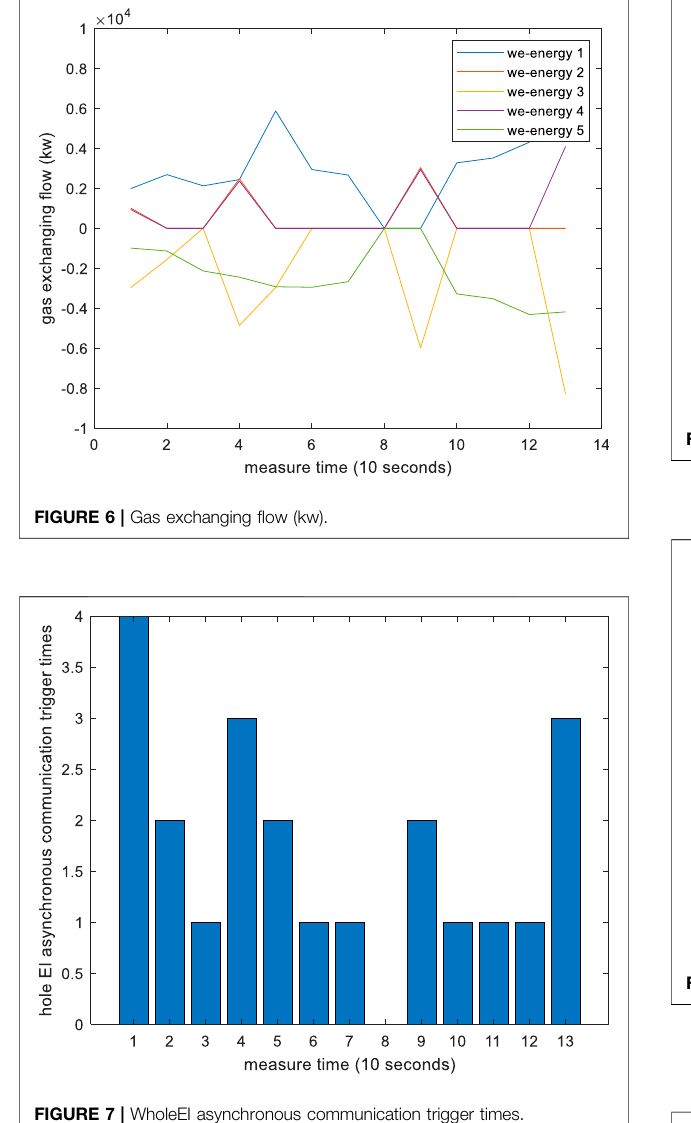
FIGURE 7 | WholeEI asynchronous communication trigger times.